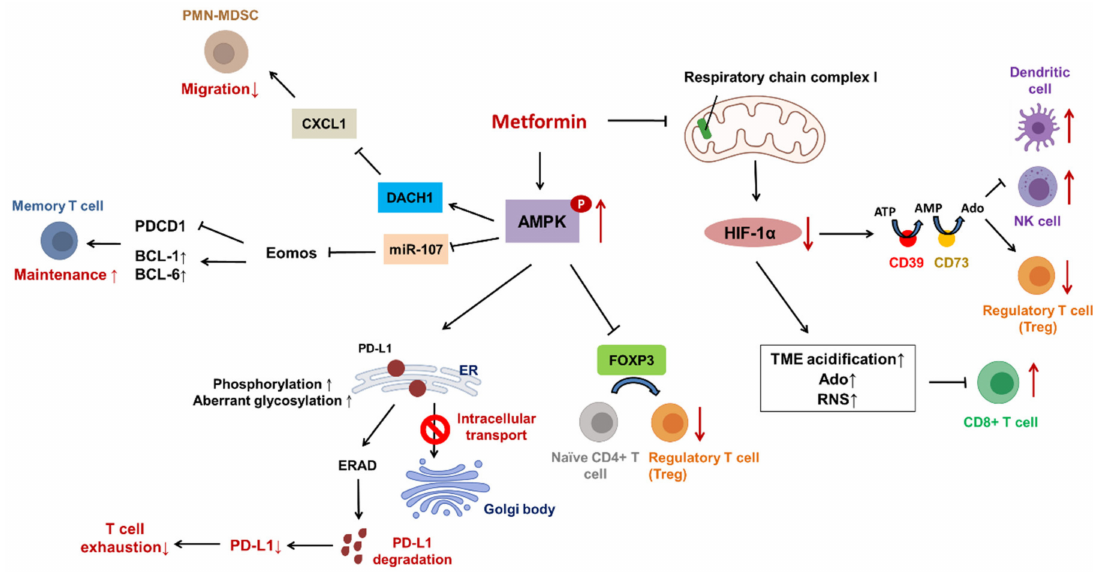
Figure 7. Metformin and its role in the modulation of cancer